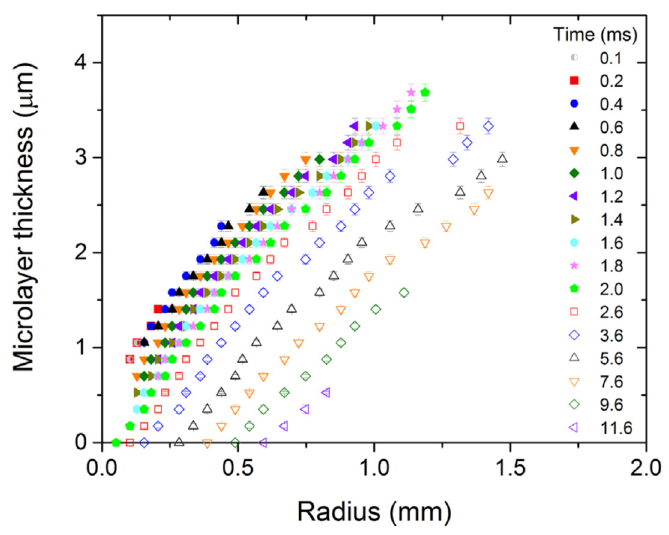
Figure 3. Sequential measurements of the radial distribution of microlayer thickness, adapted from Ref [1].